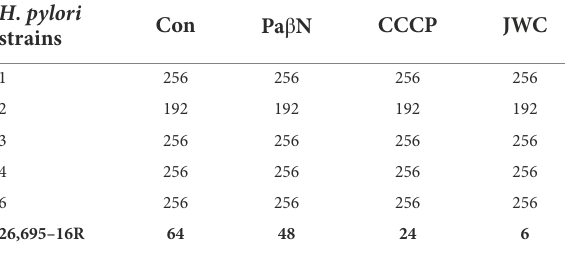
TABLE 7 Effects of JWC on MIC ( μ g/ml) of MTZ resistant strains.